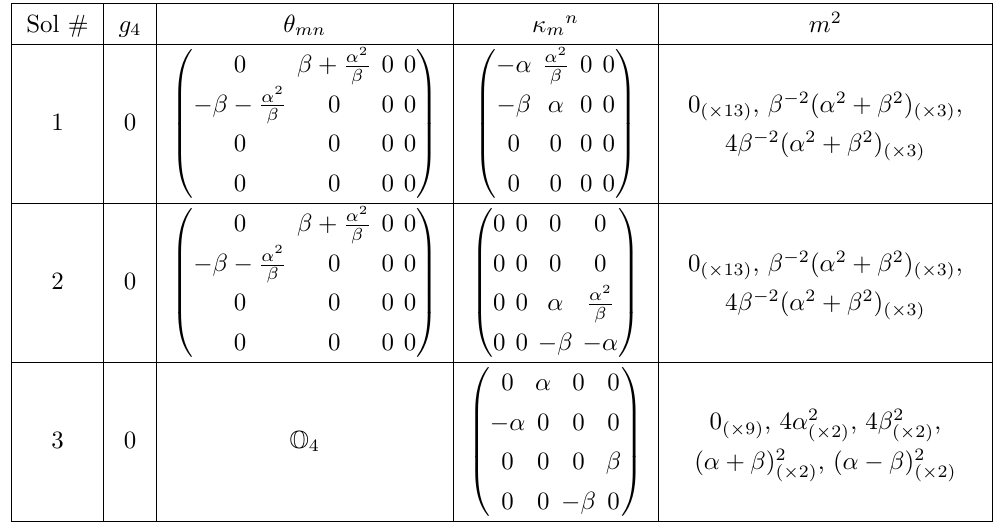
Table 29 . Critical points of the scalar potential induced by the compacti(cid:12)cation of M-theory with KKO6/KK6. In this case, we show three families of solutions depending on two parameters ( (cid:11); (cid:12) ), all of them corresponding to Minkowski